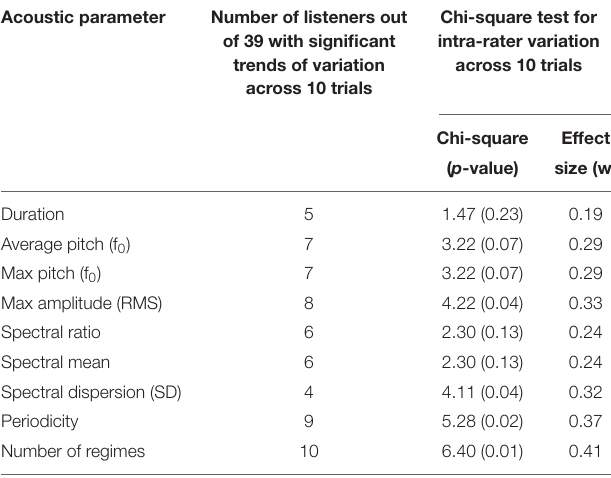
TABLE 3 | Mean distress ratings of the 39 listeners on the 42